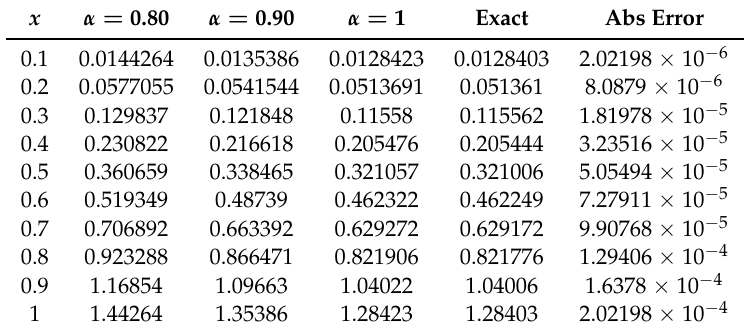
Table 7. Third order approximate results for different values of α at t = 0.25 of Example 2.